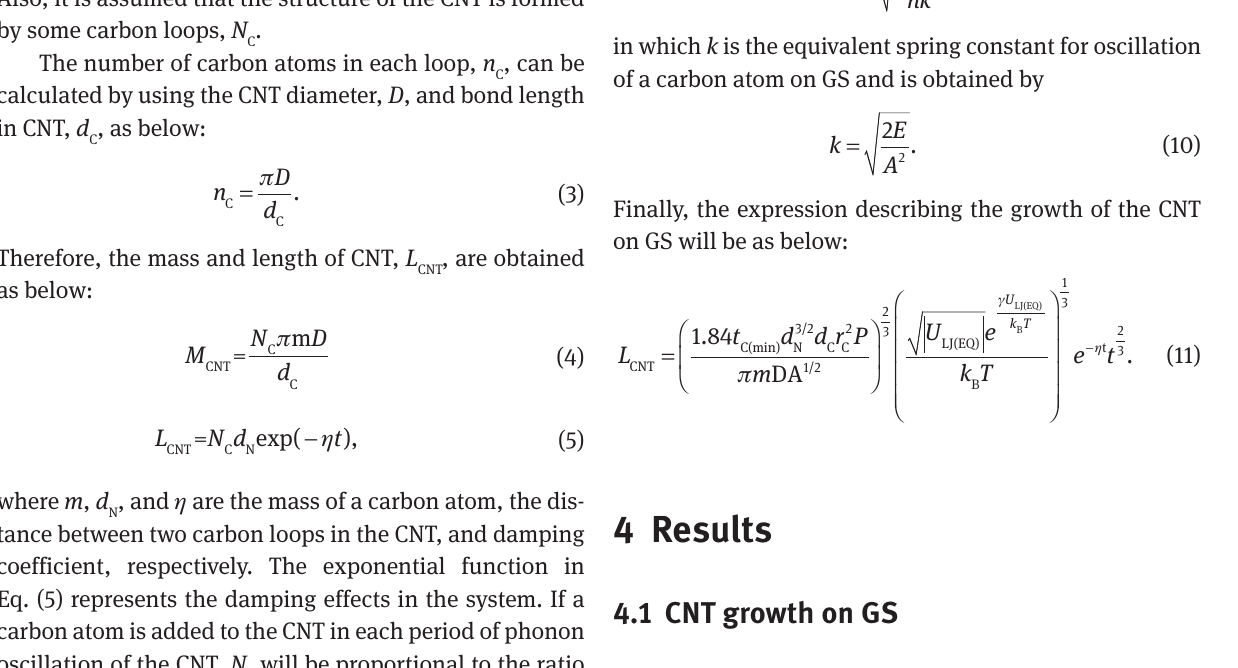
Figure 4 demonstrates that CNT grows on GS up to 300 µm. Fabrication of 3D G-CNT hybrid structure, includ- ing CNTs with such length, is reported experimentally